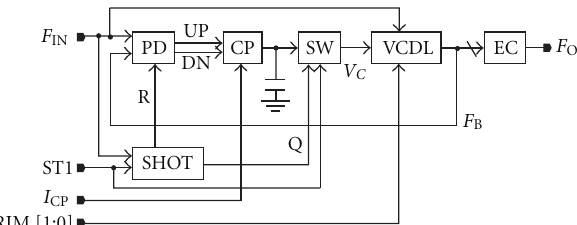
Figure 5: Block diagram of DLL1 and DLL2. In DLL1, F IN and F O are 12MHz and 60MHz, respectively. The VCDL generates 10-tap 12MHz output signals. The capacitor is 10 pF. In DLL2, F IN and F O are 60MHz and 480 MHz, respectively. The VCDL generates 16-tap 60MHz output signals. The capacitor is 0.5